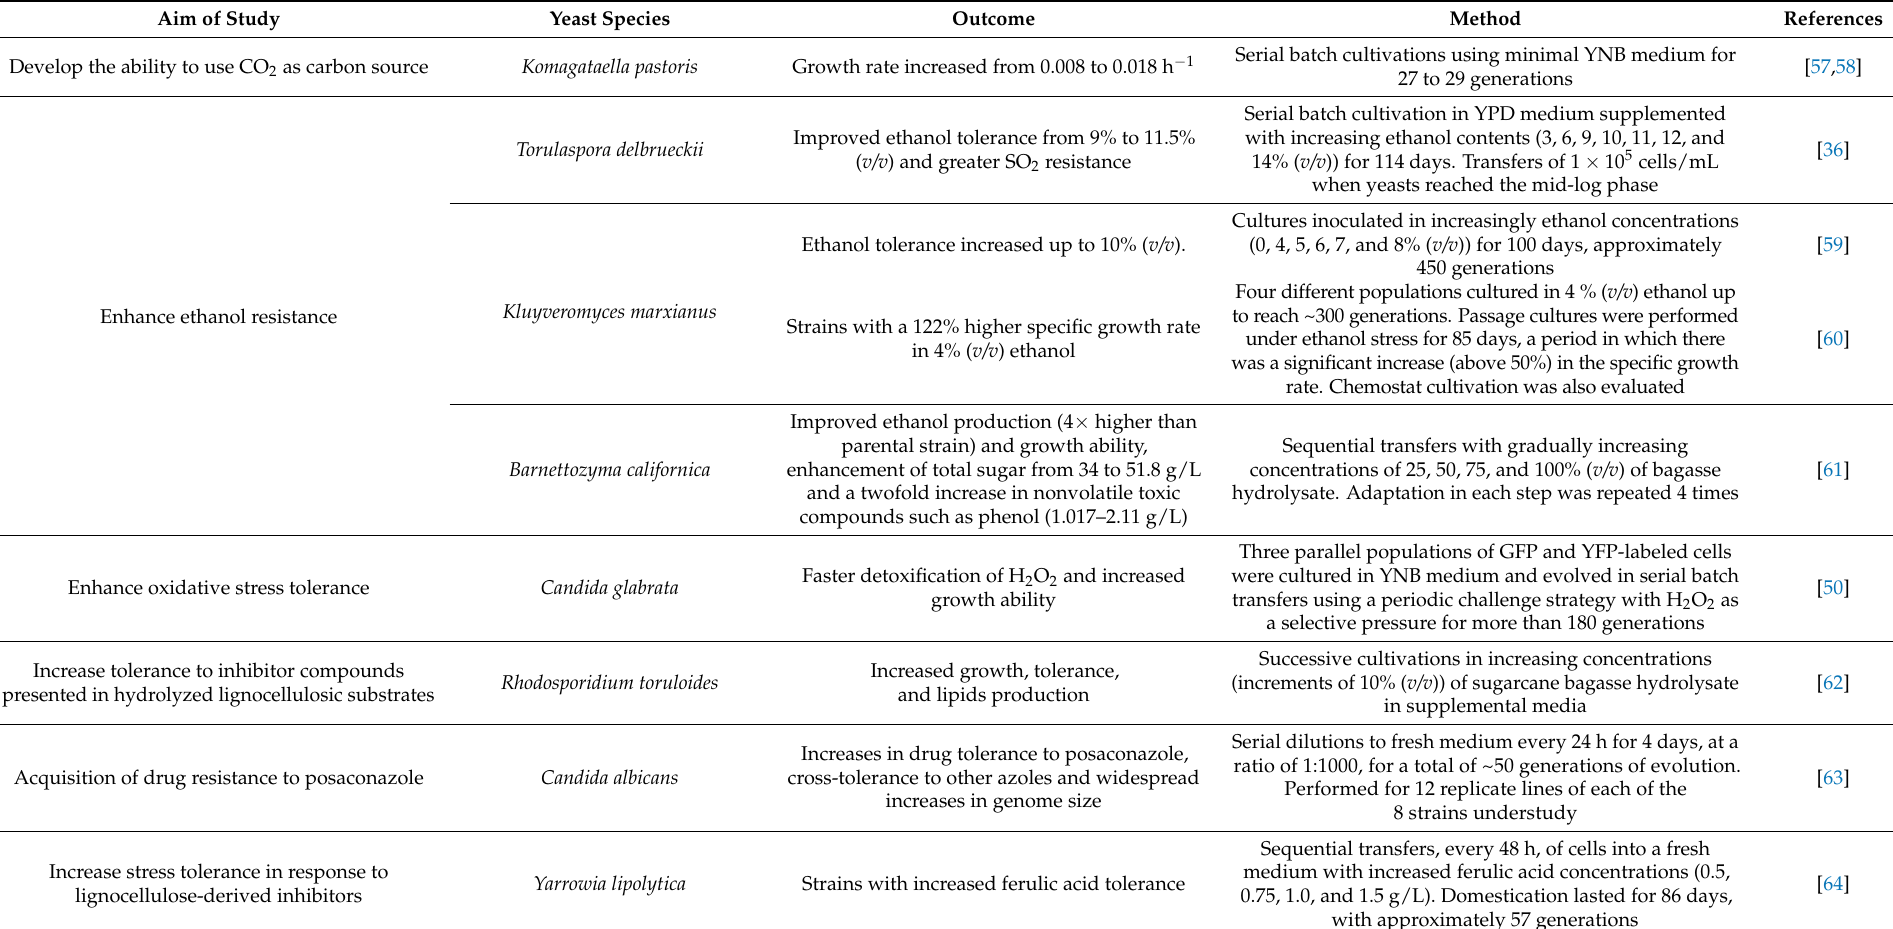
Table 2. Summary of evolution-based strategies employing non- Saccharomyces yeasts, including aim, outcome, and method employed in each